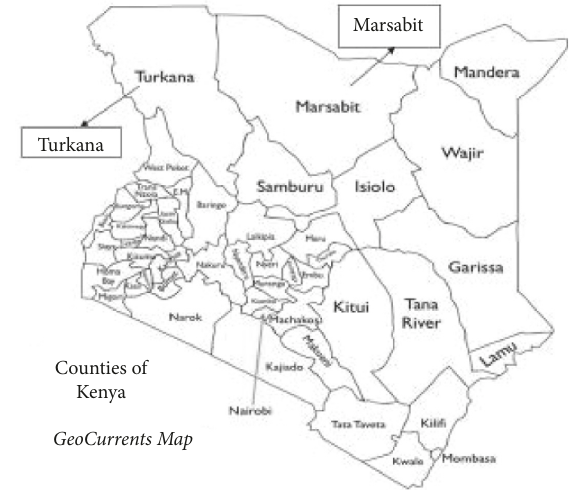
Figure 1: Location of Marsabit and Turkana Counties in